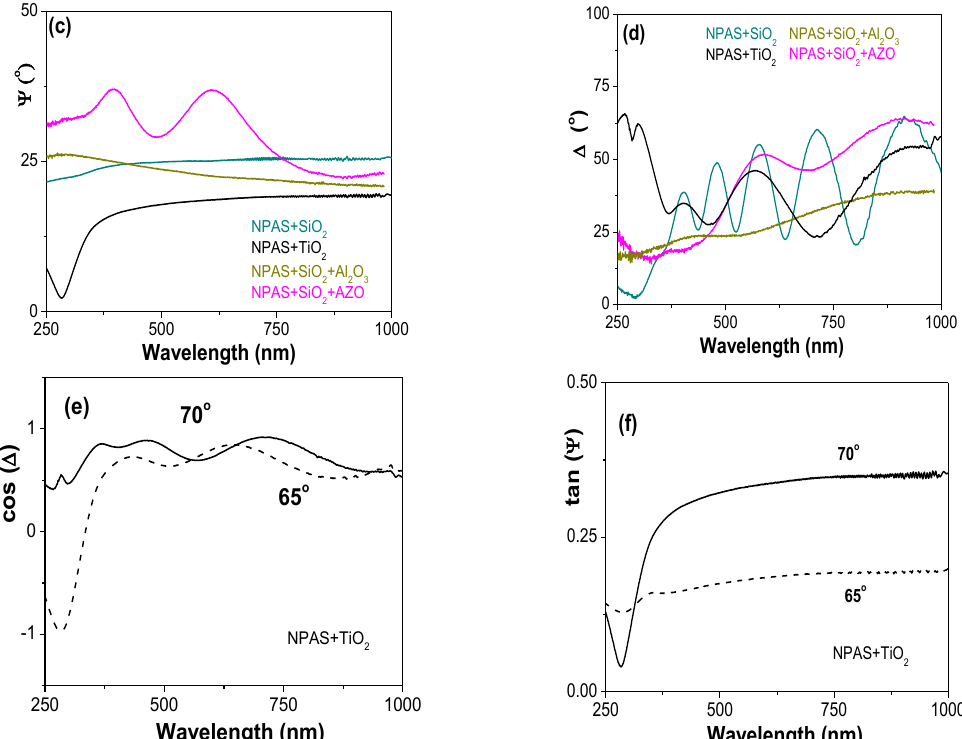
Figure 5. Wavelength dependence of cos( Δ) ( a ), tan(Ψ) ( b ), Δ ( c ) and Ψ ( d ) for: NPAS + SiO 2 (cyan), NPAS + TiO 2 (black), NPAS + SiO 2 + Al 2 O 3 (dark yellow), and NPAS + SiO 2 + AZO (pink) samples. Comparison of the measured cos( Δ) ( e ) and tan(Ψ) ( f ) values for the NPAS + TiO 2 sample at two different incident angles (65° and 70°).